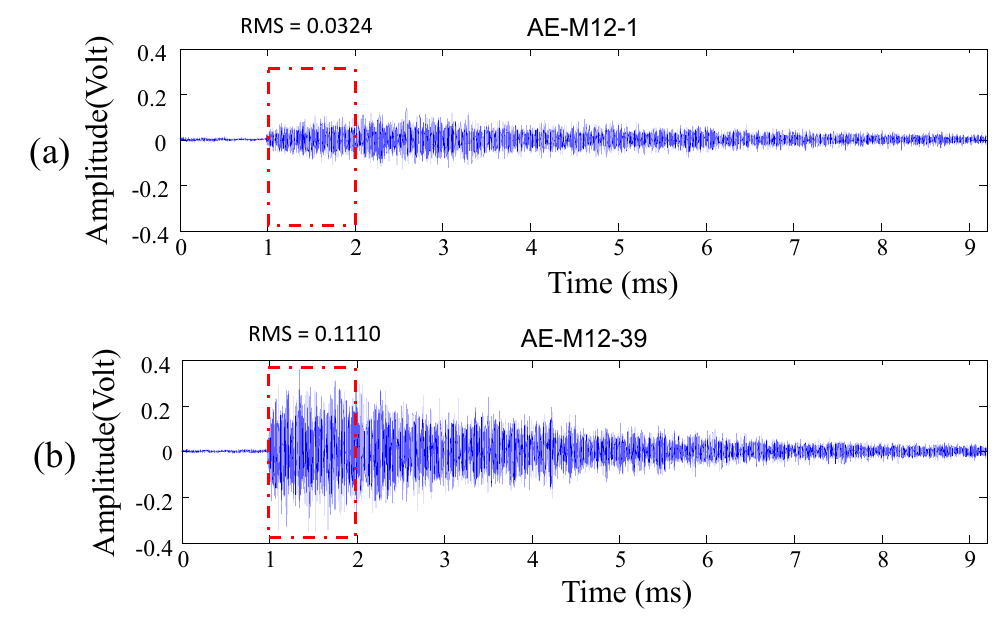
Figure 6. AE signals collected during laser microwelding for joints with ( a ) low and ( b ) normal bonding strength.